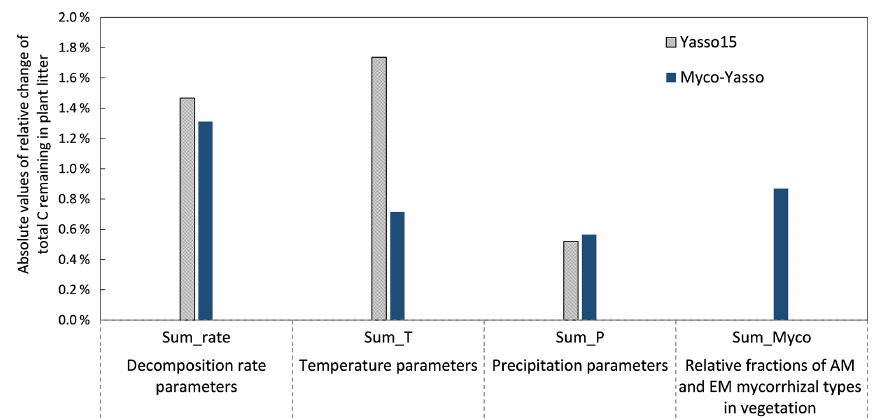
Figure C3. Model sensitivity of the Yasso15 and Myco-Yasso models to individual groups of parameters. The impact of increases by 1% of each parameter is shown.